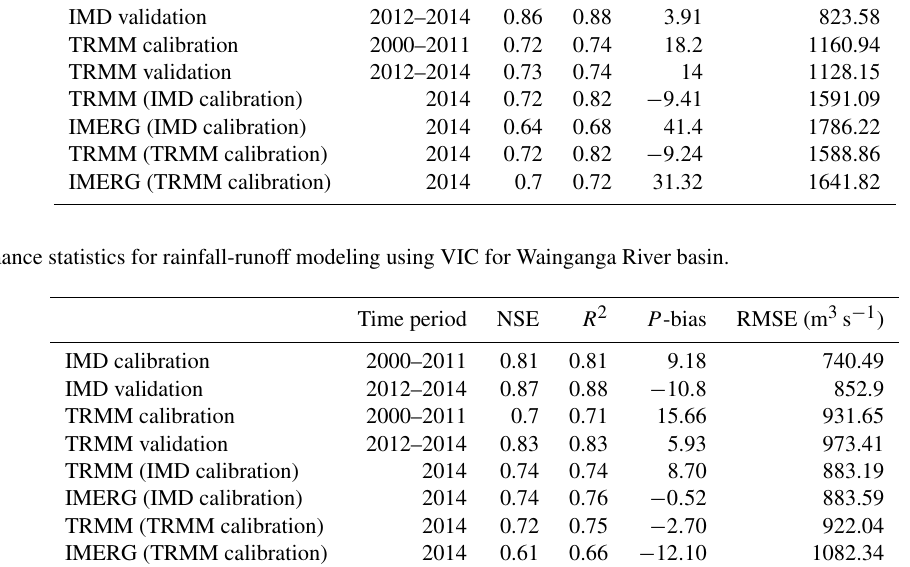
Table 7. Performance statistics for rainfall-runoff modeling using VIC for the Hirakud catchment of the Mahanadi River basin.